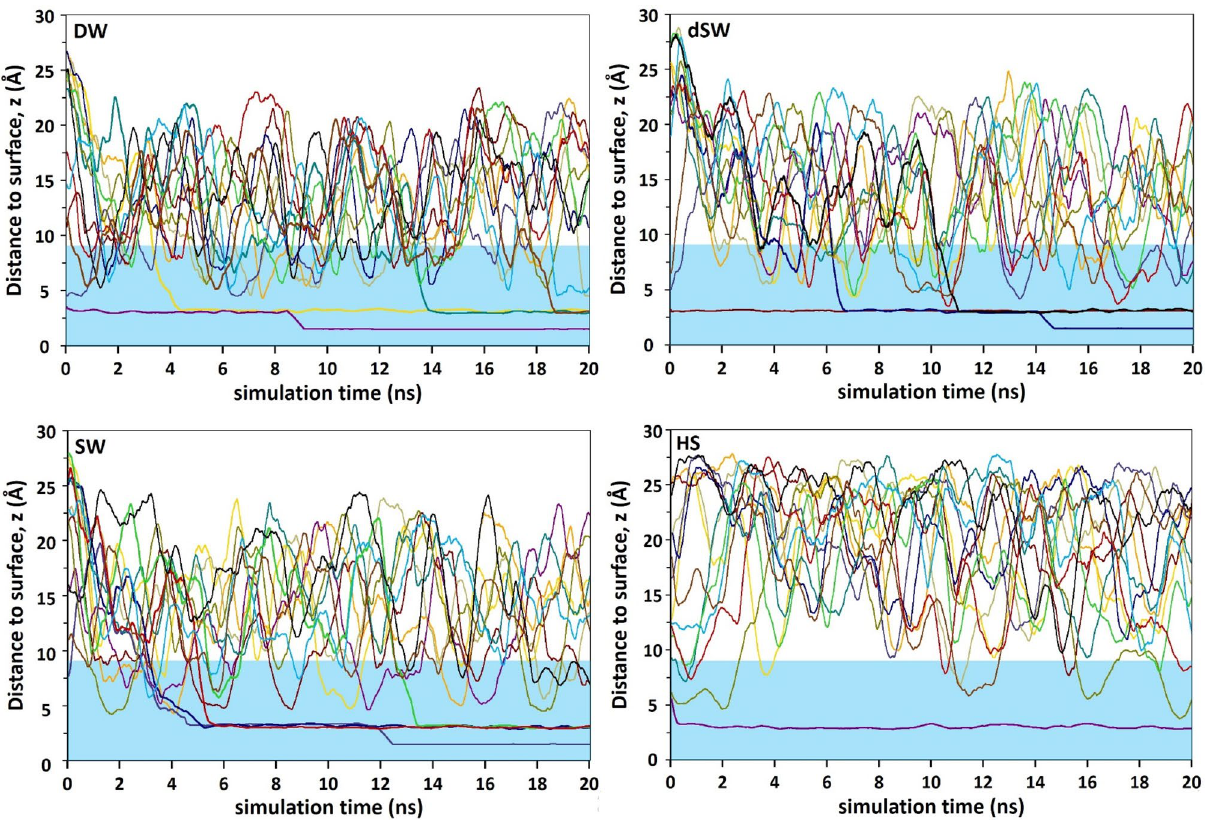
Figure 8. Vertical trajectories of BA over calcite surface at different salinities as a function of simulation time. Different BA molecules are traced by different colors. The shaded blue region corresponds to hydration layers over calcite (i.e. the ca. 1-nm thick